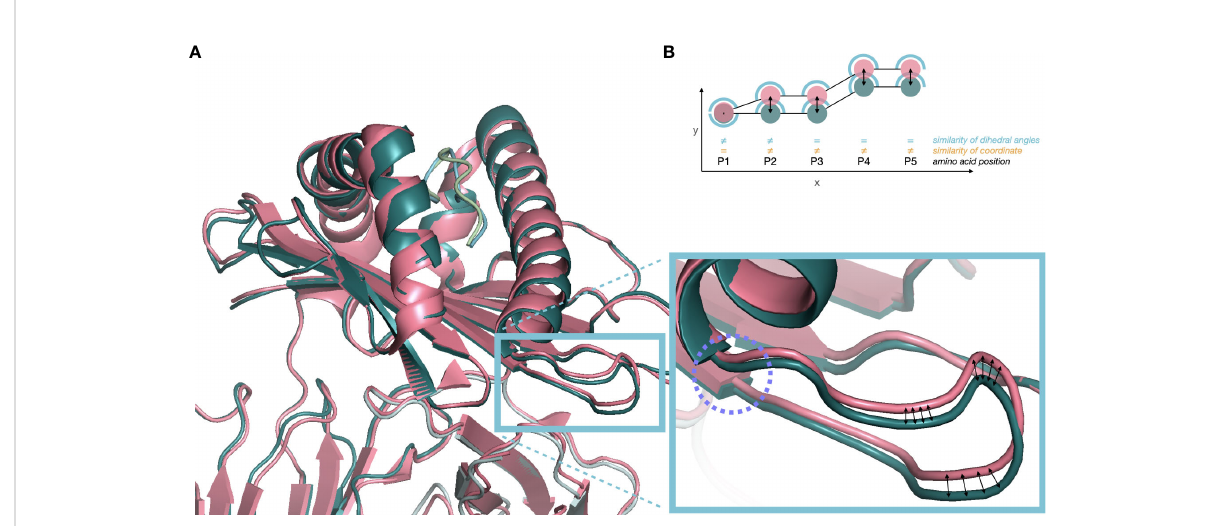
FIGURE 1 (A) Cartoon plot of two independent crystal structures of HLA-A*02:614 in overlay. In pink structure 3MRE (PDB DOI: 10.2210/pdb3MRE/pdb) and in green structure 3GSR (PDB DOI: 10.2210/pdb3GSR/pdb). Superimposition was based on atoms of identical amino acid residues. The blue box indicates small changes in dihedral angles (purple circle) propagating into large Euclidean distances in the following loop structure. (B) Euclidean distance between atom positions (orange) may overestimate the structural difference (P3-P5) due to distance-propagation of angular difference at P1/P2 (blue) or suboptimal global superimposition. However, dihedral angles at P3-P5 are identical, only considering P1/P2 as structurally